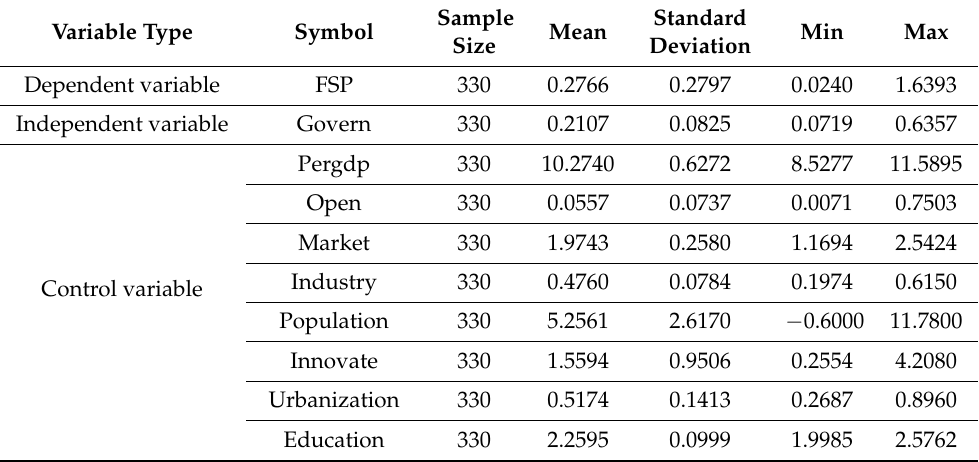
Table 2. Summary